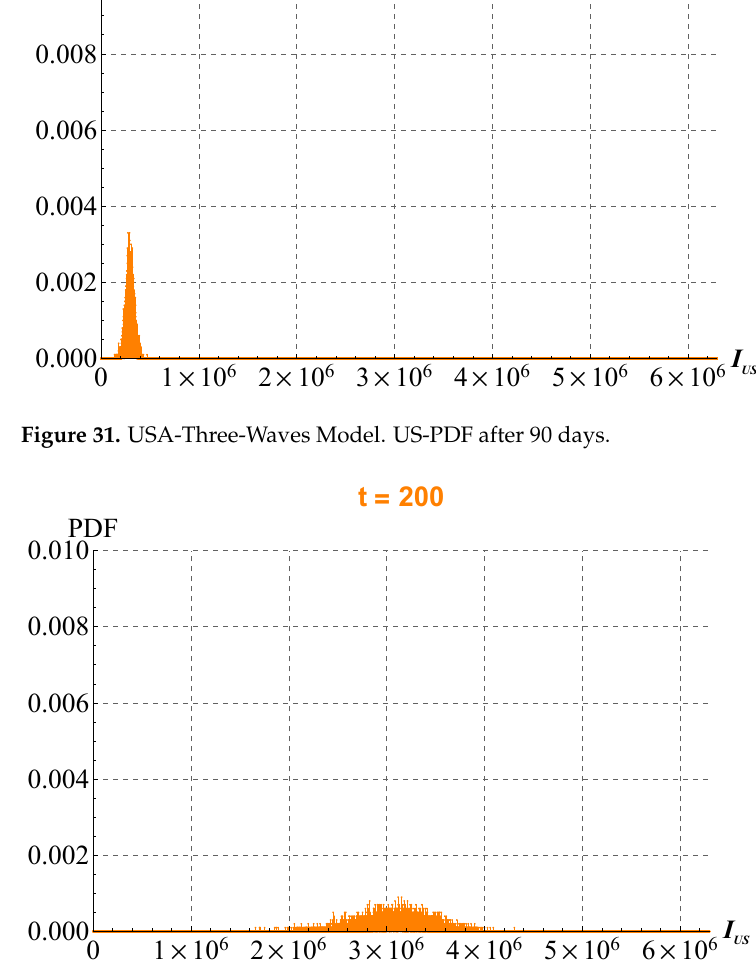
Figure 32. USA-Three-Waves Model. US-PDF after 200